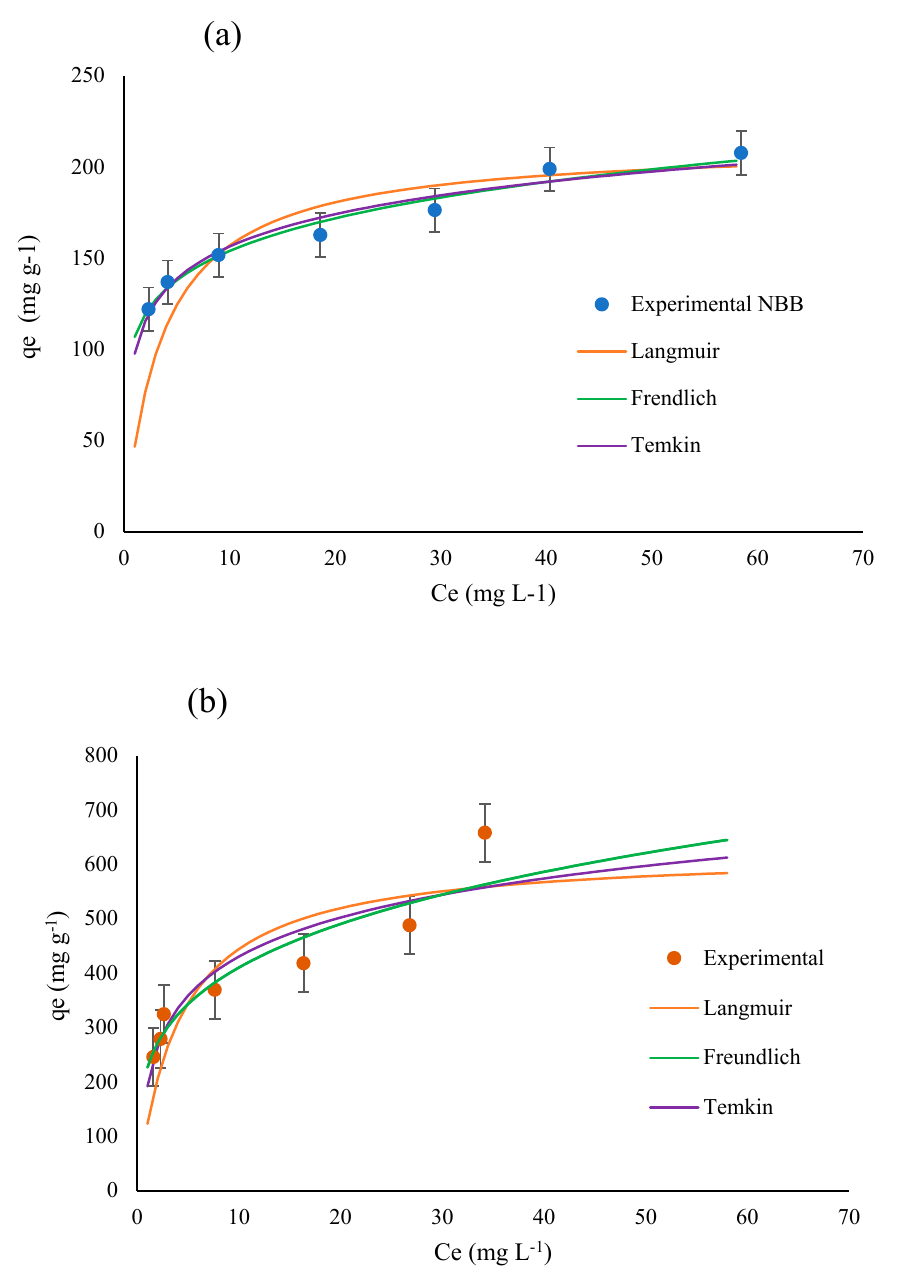
Figure 11. Adsorption isotherm models (Langmuir, Freundlich and Temkin) fitted to experimental adsorption of ( a ) NBB and ( b ) CV.